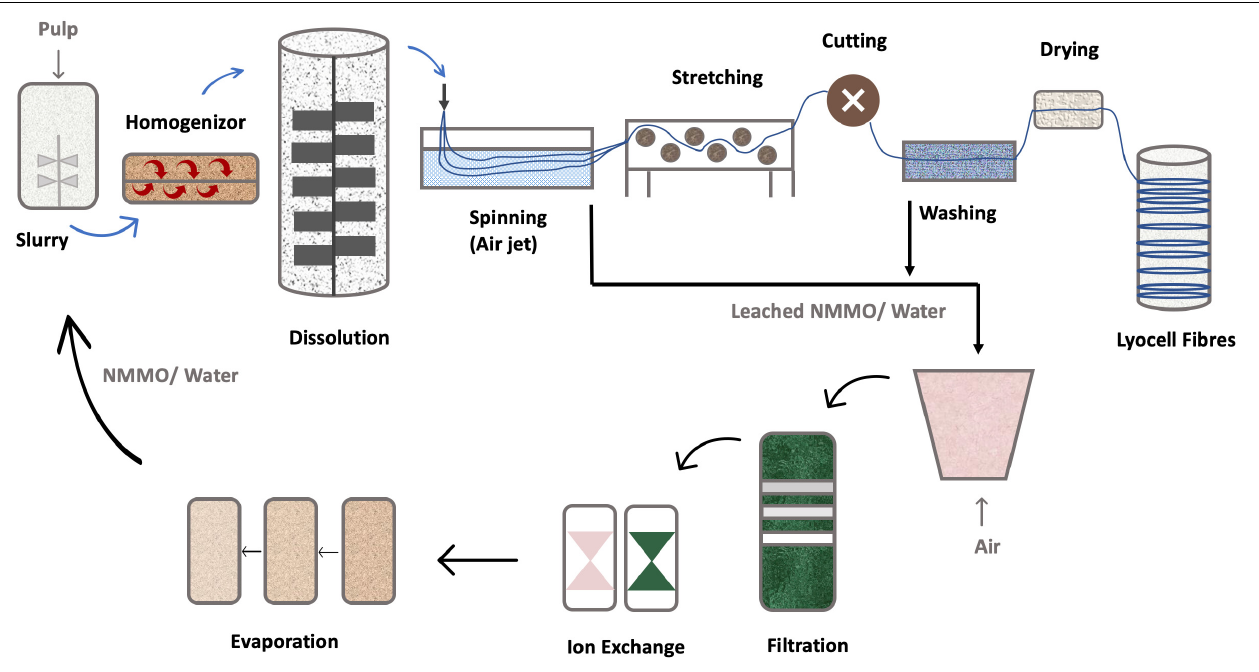
FIGURE 8 | NMMO based lyocell process [addapted from Jiang et al. (2020), Sayyed et al. (2019)].